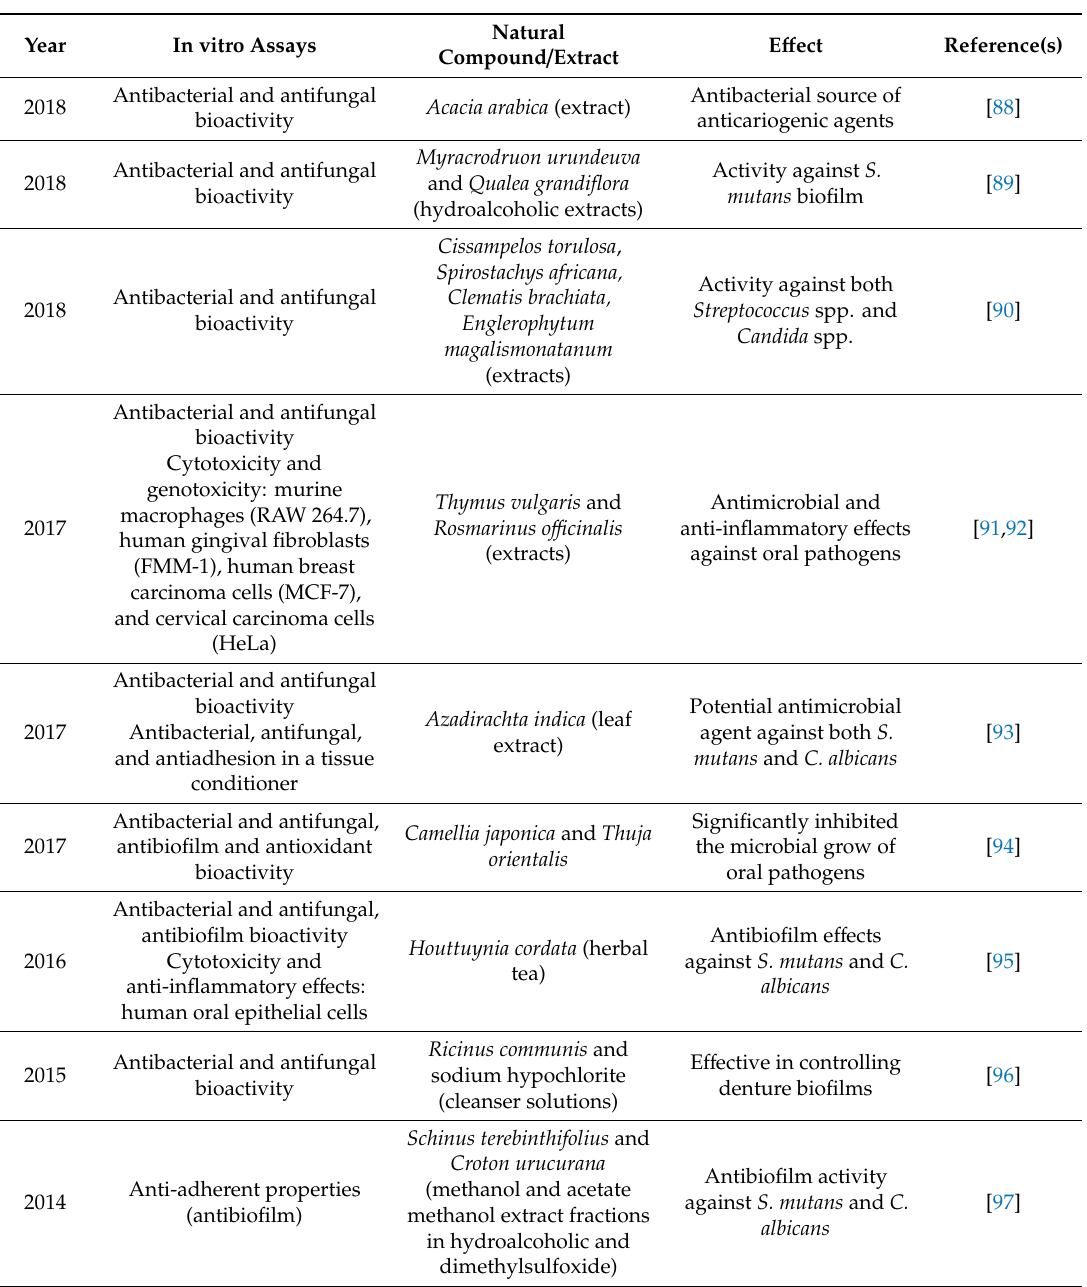
Table 2. Natural compounds / extracts and their in vitro bioactivity against Streptococcus spp. and Candida